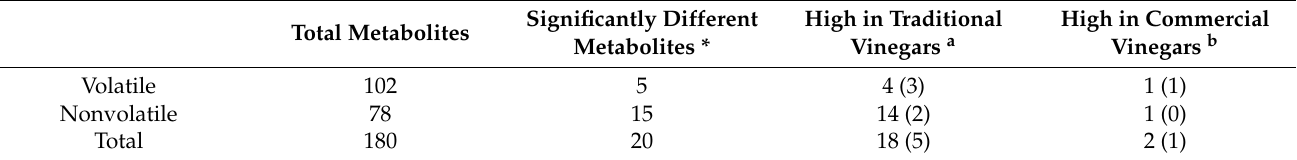
Table 2. Number of vinegar metabolites identified.